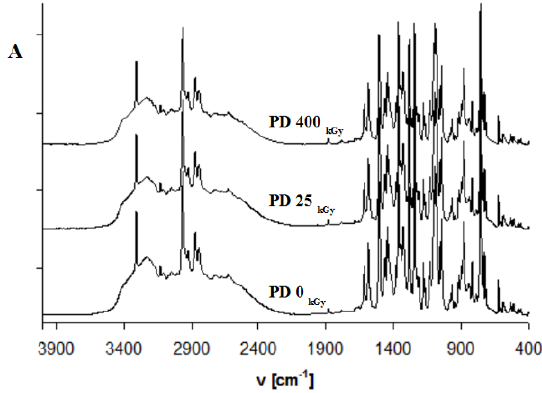
Figure 3. FT-IR spectra of pindolol before and after